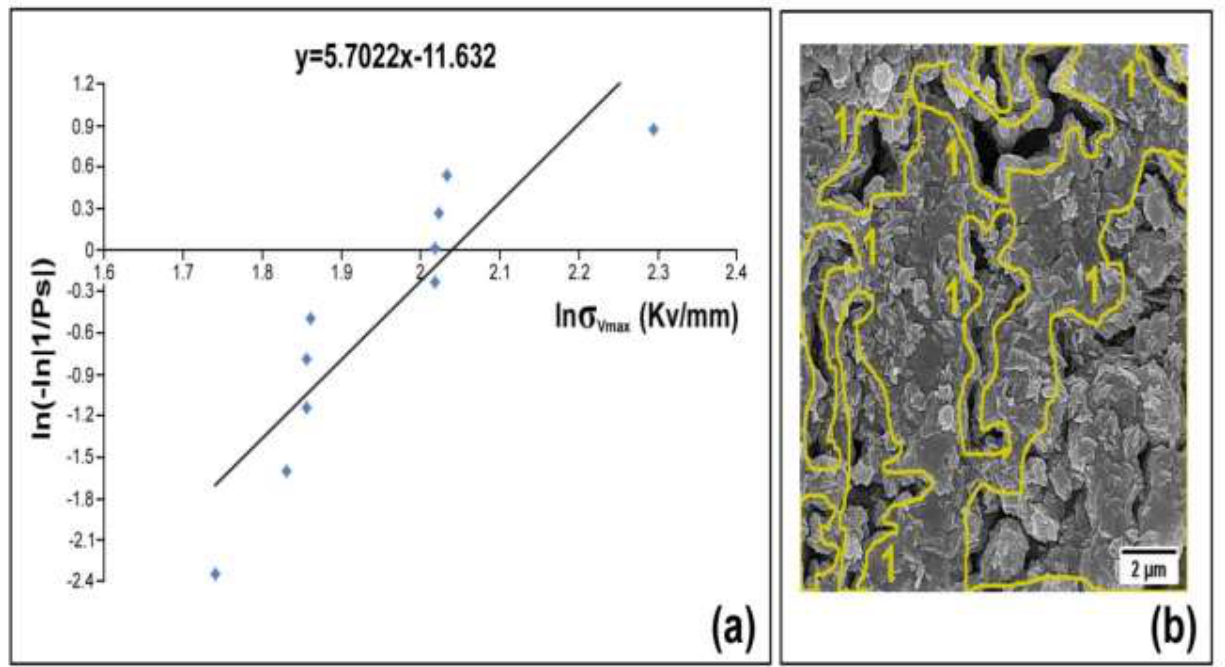
Figure 4: (a) Weibull modulus determination for LC3S as homogeneity indicator. (b) FESEM image for LC3S microstructure 2 µm .